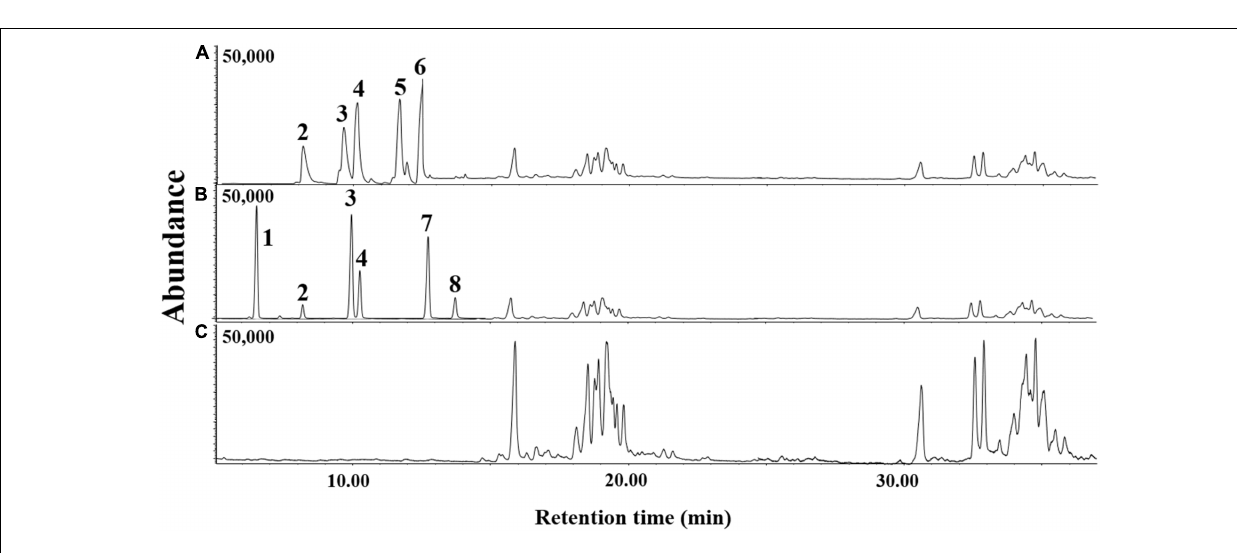
FIGURE 7 | GC-MS chromatograms of dichloromethane extracts of A. niger (A) and E. clematidis (B) culture supernatant in the presence of Impranil as the sole carbon source, and Impranil liquid medium without culturing of fungi (C) after 2-week